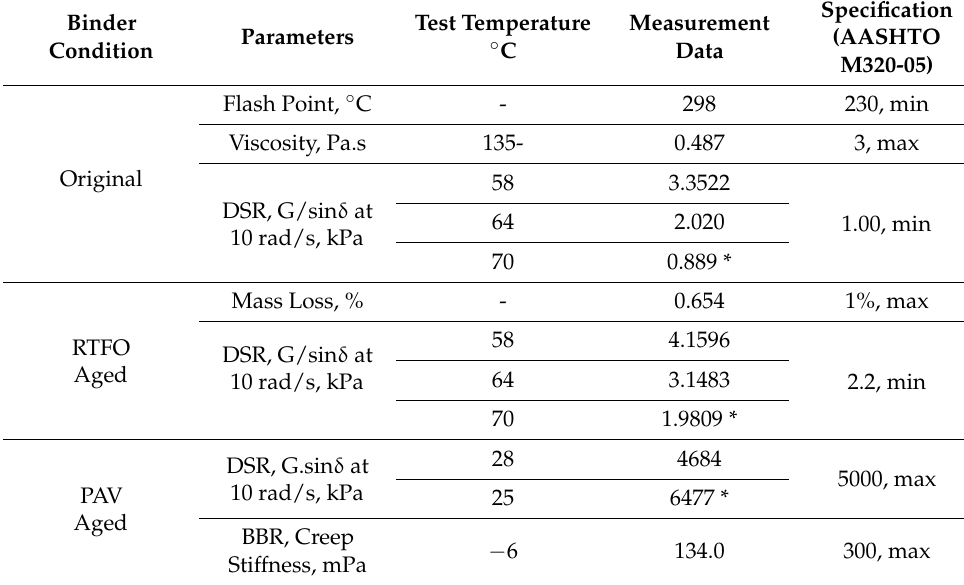
Table 1. Physical properties of the asphalt cement.